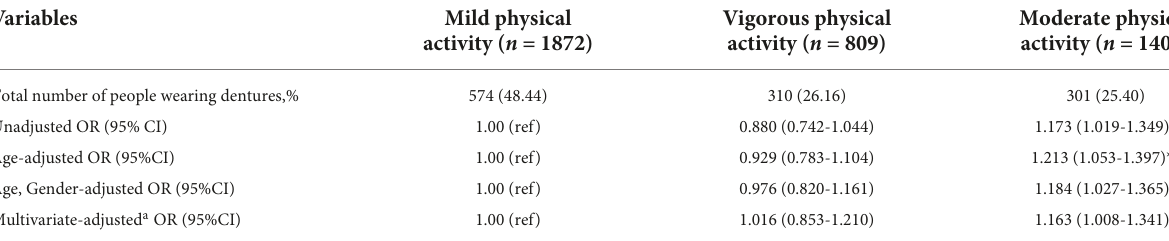
TABLE 3 Association between wear dentures status and physical activity by multivariate logistic regression models in older adults without cognitive impairment.